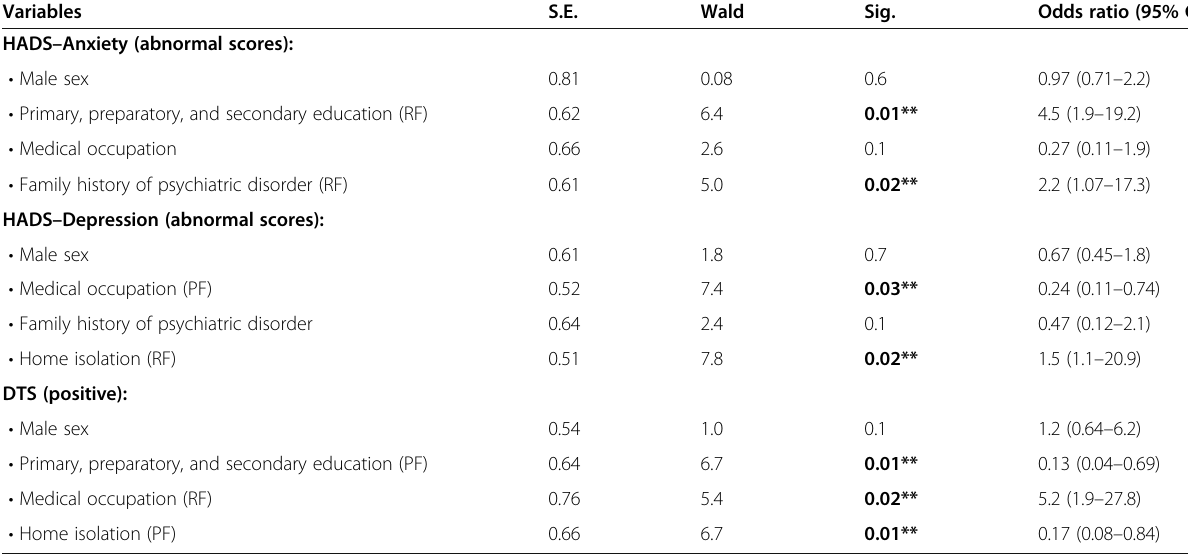
Table 6 Binary logistic regression analysis of HADS scores and DTS scores with significantly related independent factors Variables